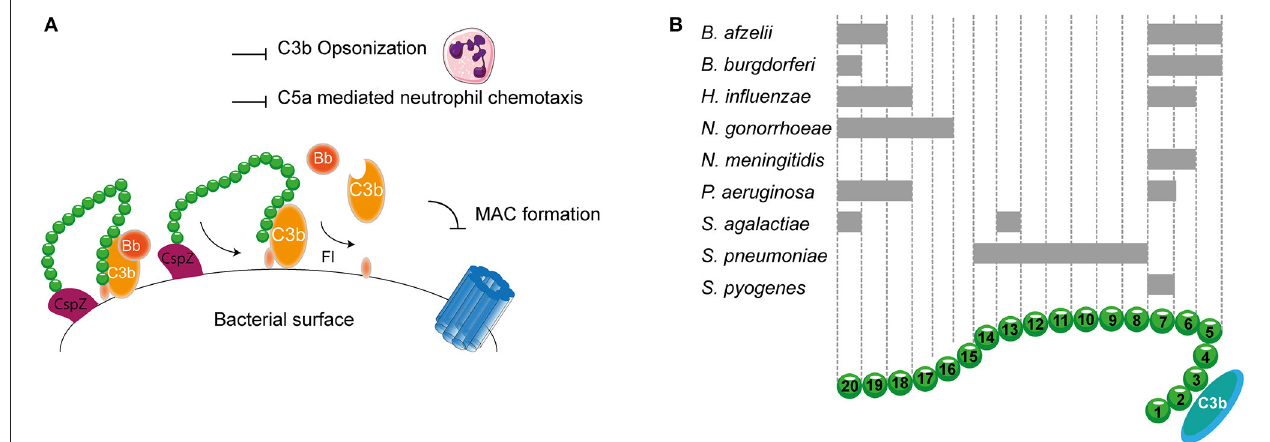
FIGURE 5 | FH binding by bacterial pathogens. (A) One example of a FH binding bacterial protein is the surface protein CspZ of B. burgdorferi . CspZ interacts with SCR 20 of FH recruiting this AP regulator to the bacterial surface resulting in the decay of the AP C3 convertase and proteolytic degradation of C3b into iC3b and C3d. This subsequently inhibits formation of the MAC as well as decreases phagocytic uptake of the bacteria due to the inhibition of C3b deposition and C5a generation. (B) Multiple bacteria can bind FH at different sites as indicated by the gray rectangles. SCRs 1-4 mediate the interaction with C3b and SCRs 19-20 are involved in recognizing self from non-self. Figure was produced using Servier Medical